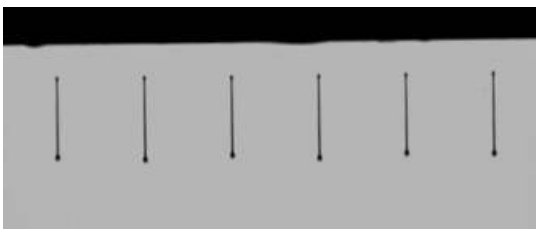
Figure 11. The image of ink-jet